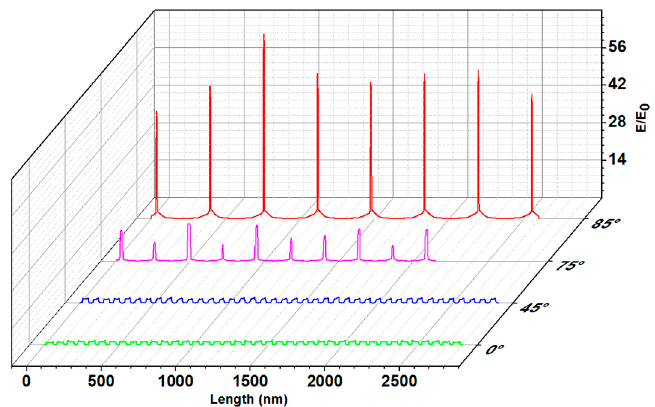
Figure 15. Curves of the local electric field along the array direction generated by the nanocolumns obtained under different deposition angles in simulation.